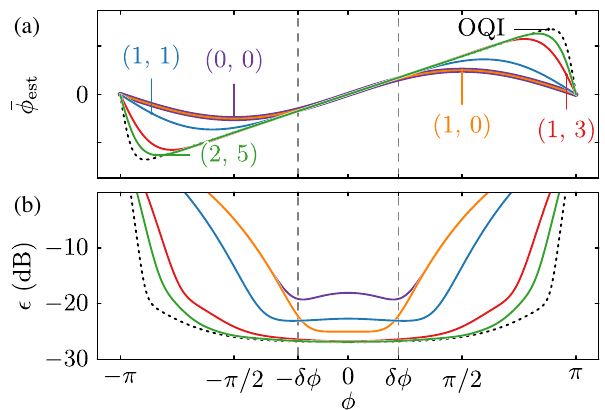
FIG. 4. (a) Phase ϕ dependence of the estimator expectation value [Eq. (11)] of the optimized N ¼ 64 particle interfero- meter at different circuit depths ð n variational parameters, in comparison to the optimal quantum interferometer (OQI). The optimization is performed for the prior distribution width δϕ ≈ 0 . 7 , indicated by the vertical lines. (b) Mean squared error [Eq. (8)] corresponding to the estimator expectation values curves above.